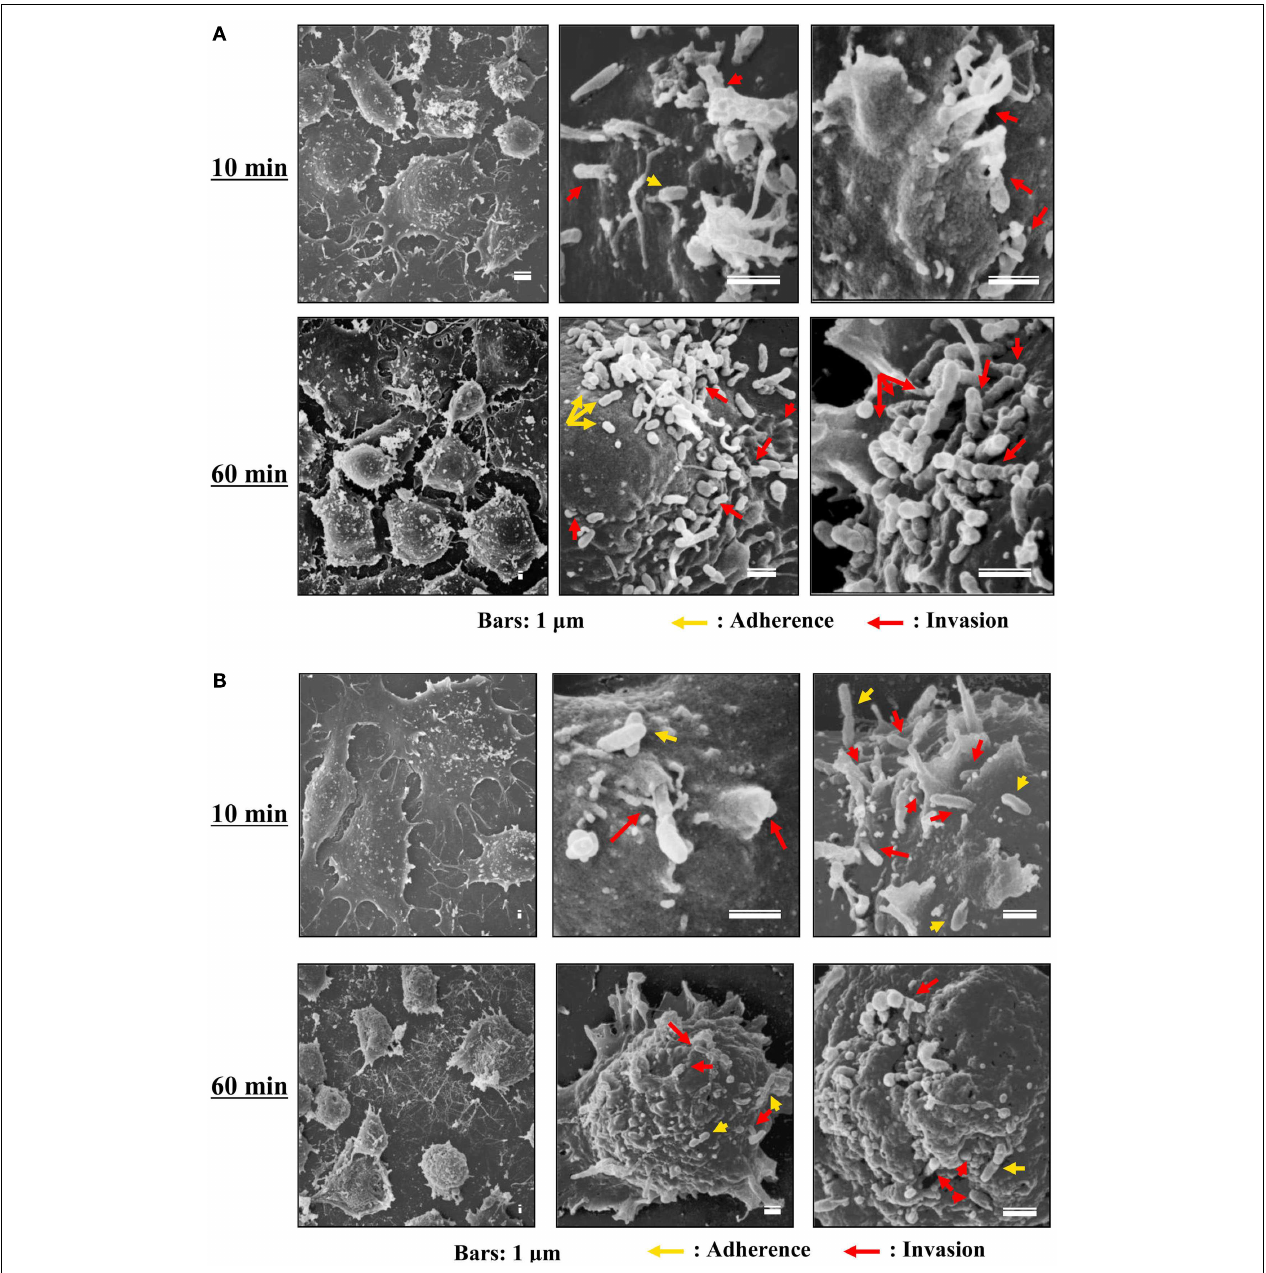
Successful adherence to and invasion of AeAl2 insect cells was achieved by bothTGR and SFGR soon after their inoculation.The yellow and red arrows indicate adherent and invading rickettsiae,